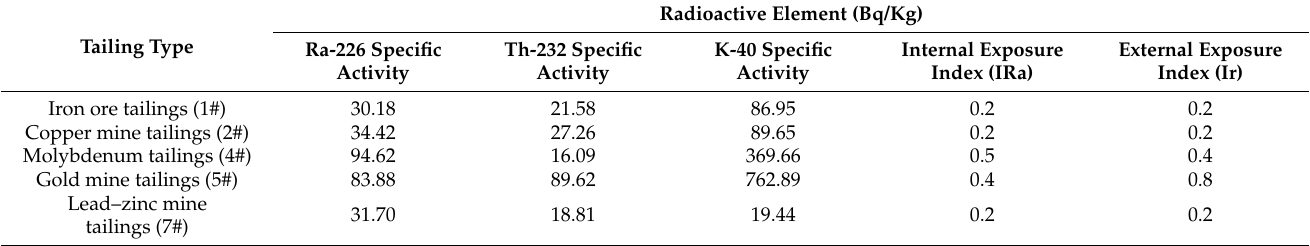
Table 6. Characteristics of radioactive elements in different tailings of typical mining areas in Tibet Autonomous